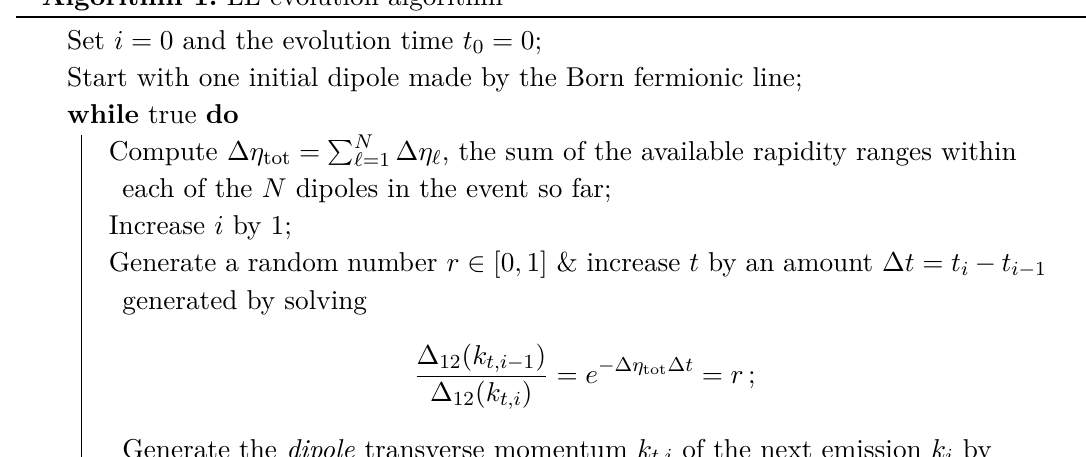
Algorithm 1: LL evolution